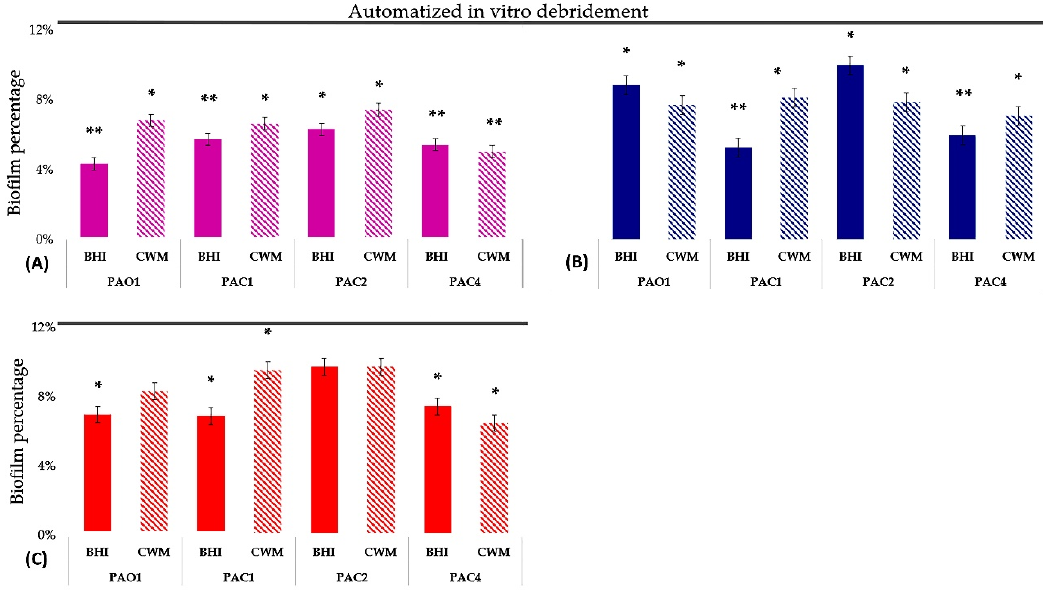
Figure 2. Percentage of biofilm reduction in pre-formed P. aeruginosa biofilms using commercialized concentrations of three antiseptics (sodium hypochlorite ( A , pink), PHMB ( B , blue) and octenidine ( C , red)) in BHI and CWM. In vitro automatized debridement left a mean of 12% of biofilm in the microfluidic channel before antiseptic treatment after 72 hr of culture. The mean percentage of biofilm after in vitro automatized debridement and before antiseptic treatment is represented by the dashed line. Samples were tested in six independent experiments. Results are presented as the mean ± standard deviation. Statistics were performed using a t-test using the R ® software version 4.0.2 to compare the efficiency of antiseptics on biofilms after in vitro automatized debridement. *, p < 0.1; ** p < 0.01.